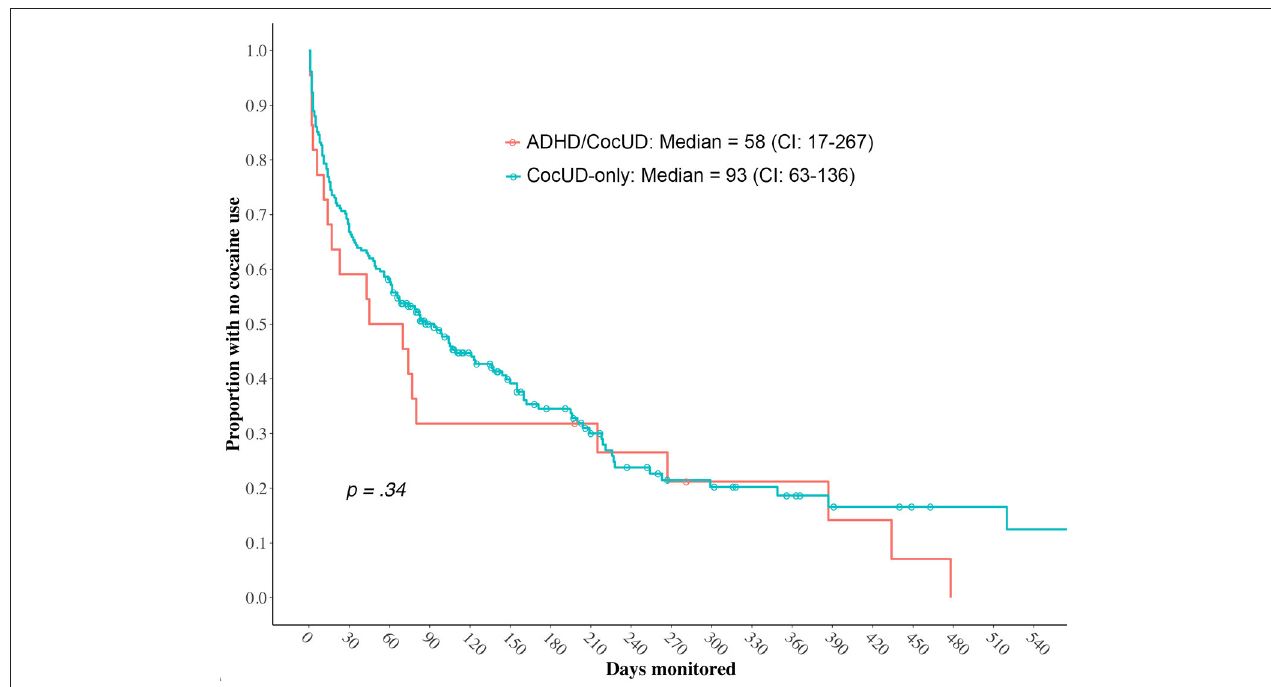
FIGURE 1 | Time to the first resumption of cocaine in ADHD/CocUD and CocUD-only groups. ADHD, attention-deficit/hyperactivity disorder; CocUD, cocaine use disorder.